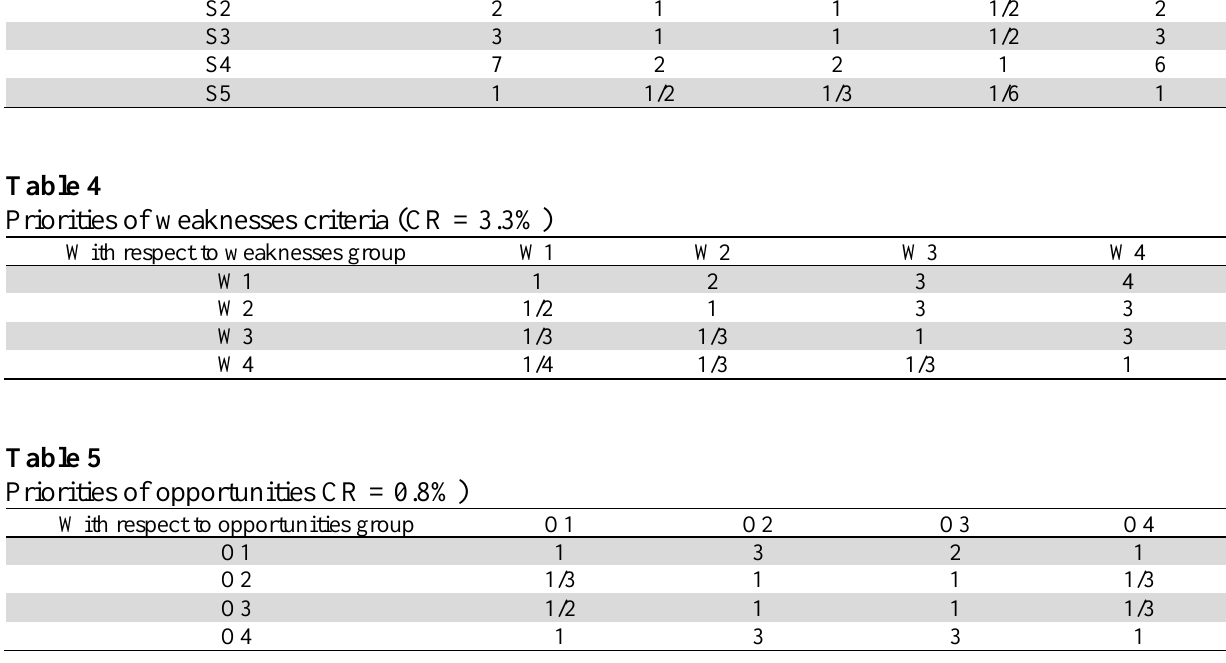
Priorities of Strengths criteria (CR = 0.8%) With respect to strengths group